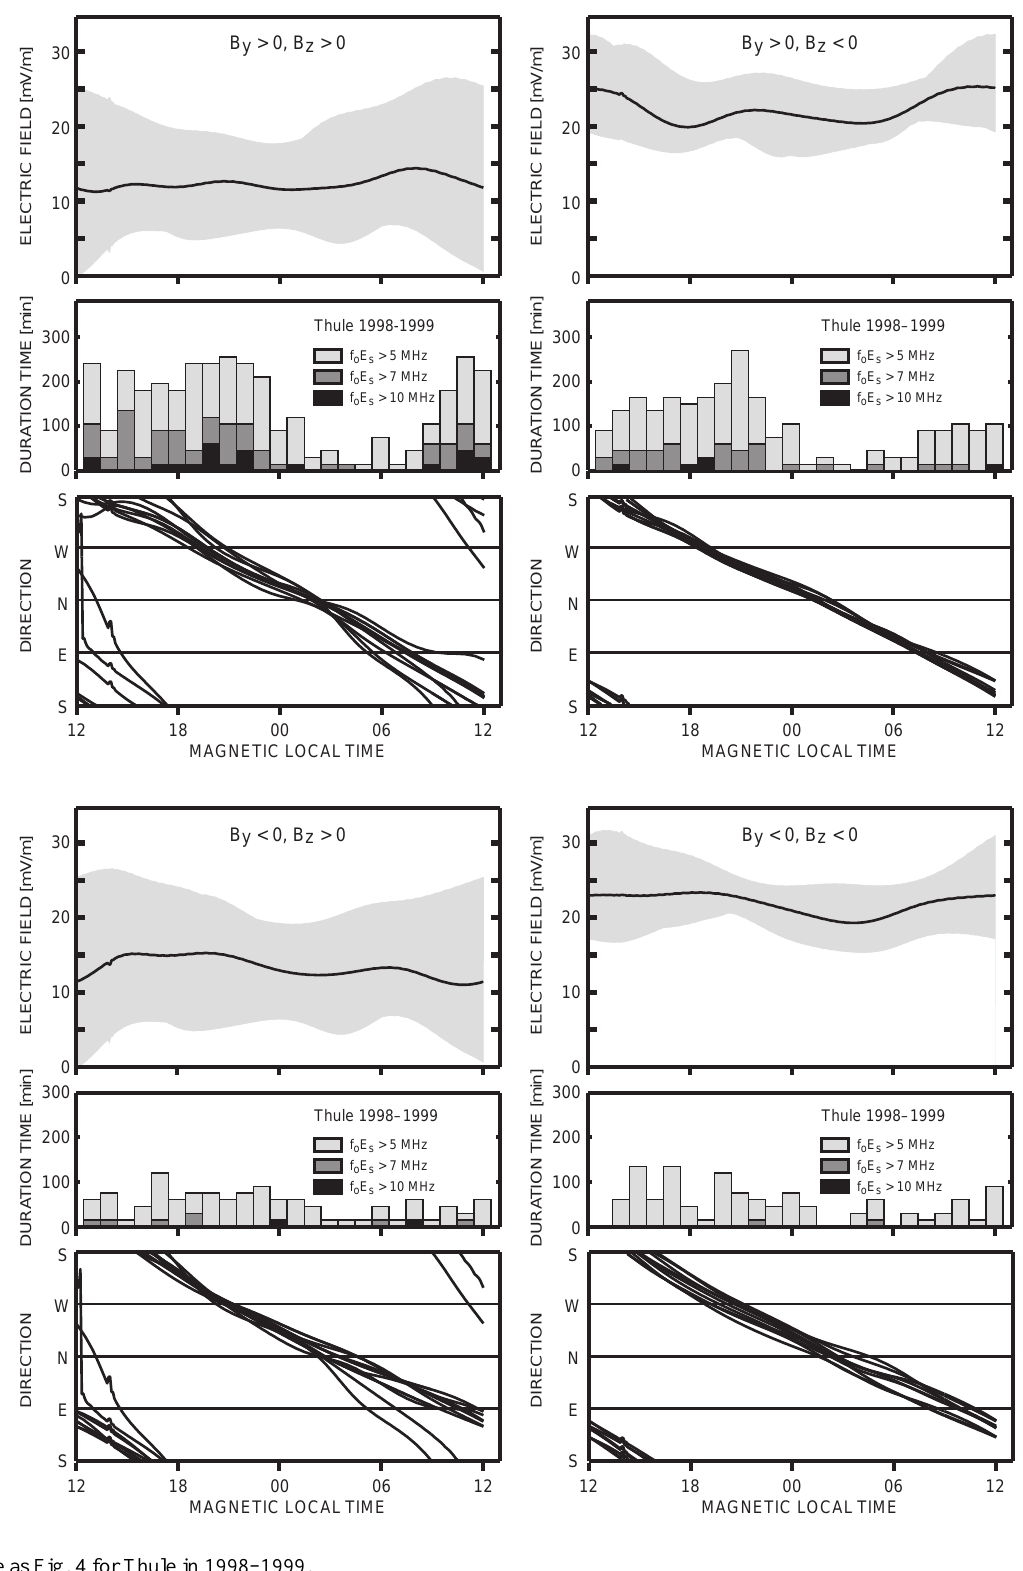
Fig. 5. Same as Fig. 4 for Thule in